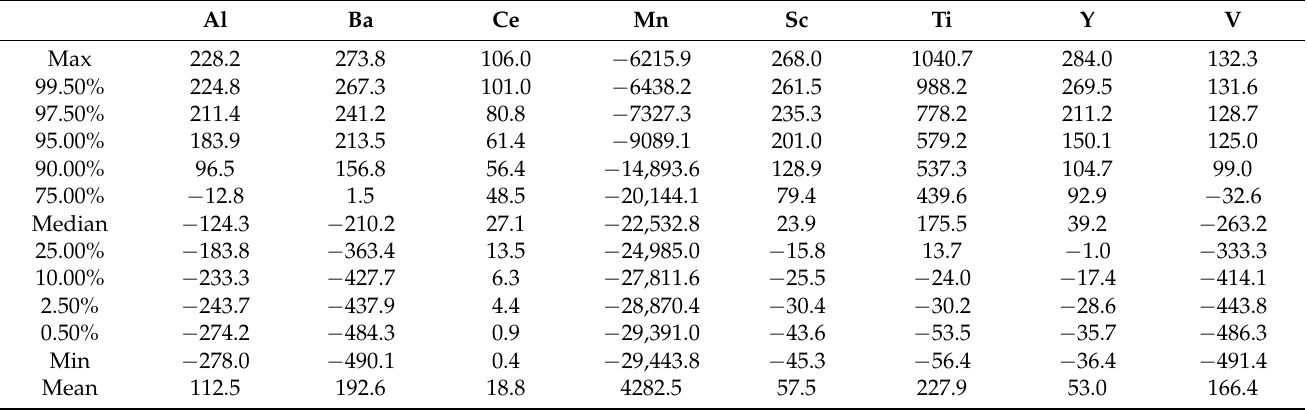
Table 1. The result of each day soil ingestion rate (SIR, mg/day) for 62 children based on tracer elements including Al, Ba, Ce, Mn, Sc, Ti, Y, and